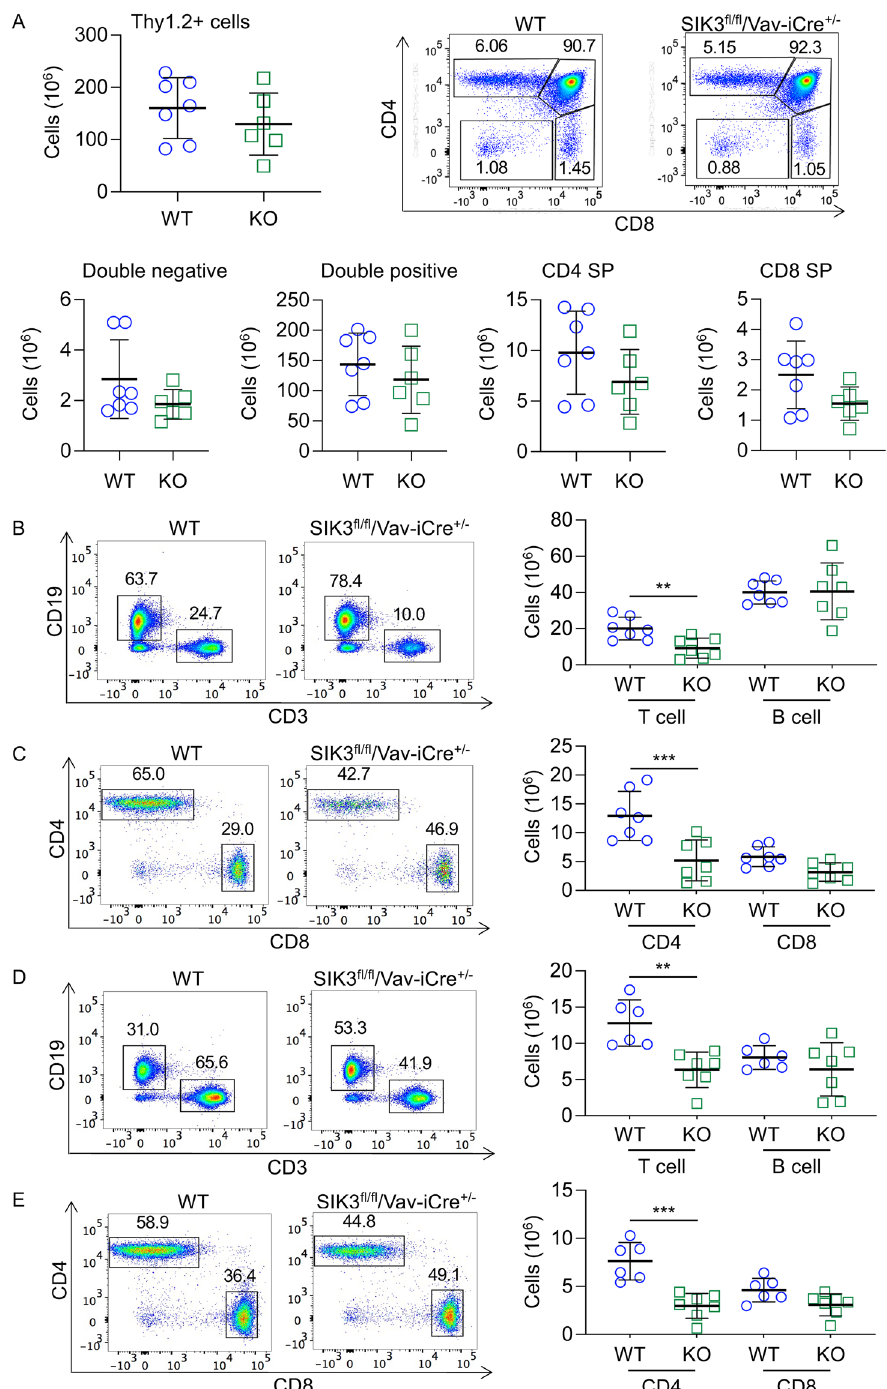
Figure 2. SIK3 fl/fl /Vav-iCre +/- mice have reduced numbers of T cells in the spleen and lymph nodes. Thymi, spleen and lymph nodes were isolated from wild type (WT) and SIK3 fl/fl /Vav-iCre +/- (KO) mice and analysed by flow cytometry. ( A ) Representative CD4 / CD8 plots of Thy1.2 +ve cells in the thymus and graphs for absolute numbers of Thy1.2 +ve , DN, DP, CD4 SP and CD8 SP cells. ( B ) Numbers of CD3 +ve T cells and CD19 +ve B cells in the spleen, along with representative FACS plots. ( C ) Absolute numbers of CD4 and CD8 T cells and representative CD4 / CD8 plots of CD3 +ve cells in the spleen. ( D ) Numbers of CD3 +ve T cells and CD19 +ve B cells in the lymph nodes, along with representative FACS plots. ( E ) Absolute numbers of CD4 and CD8 T cells and representative CD4 / CD8 plots of CD3 +ve T cells in the lymph nodes. Graphs show mean with symbols representing measurements from individual mice. Differences between wild type and knockout mice were analysed by Student’s t-test for the Thy1 +ve cell graph and by RM two way ANOVA with Sidak’s post hoc testing for the other graphs. p < 0.05 is indicated by *, < 0.01 by ** and < 0.001 by ***. Graphs show n = 6 for analysis of thymi, n = 7 or n = 6 for wild type and SIK3 knockouts for spleens and n = 6 for wild type and n = 7 for SIK3 knockout lymph